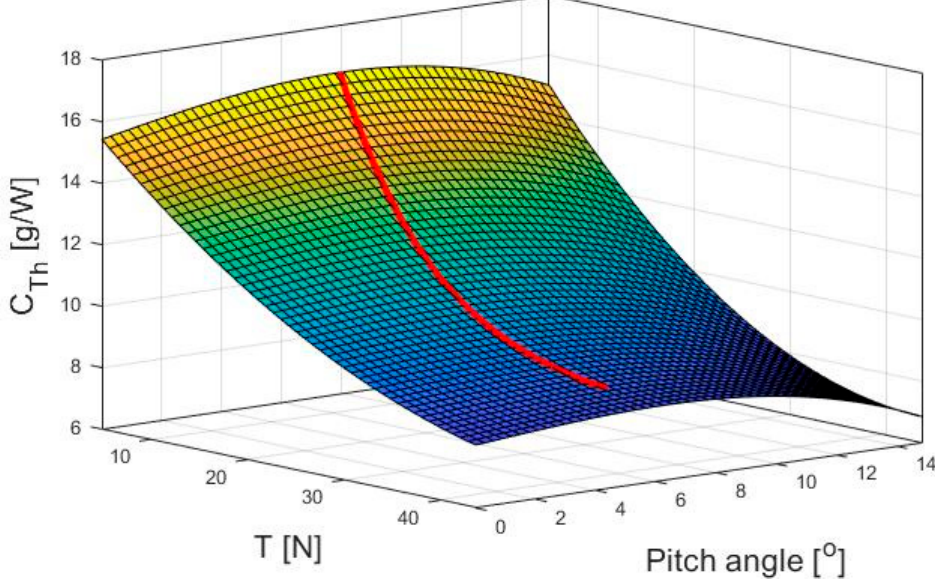
Figure 10. C Th in for various pitches at specific thrust.